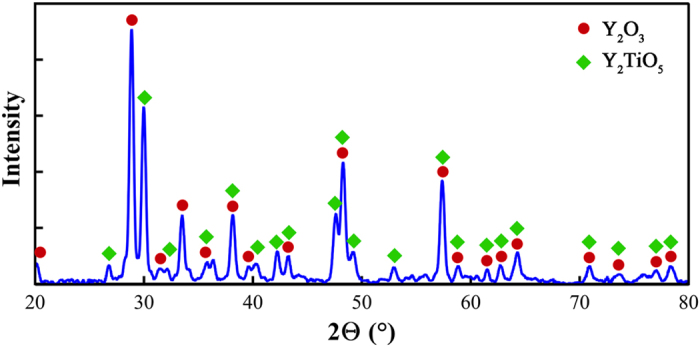
The XRD pattern of precipitates extracted from FeNiMn-Y-TiO2 specimen shown in SEM and TEM images (Fig. 3).